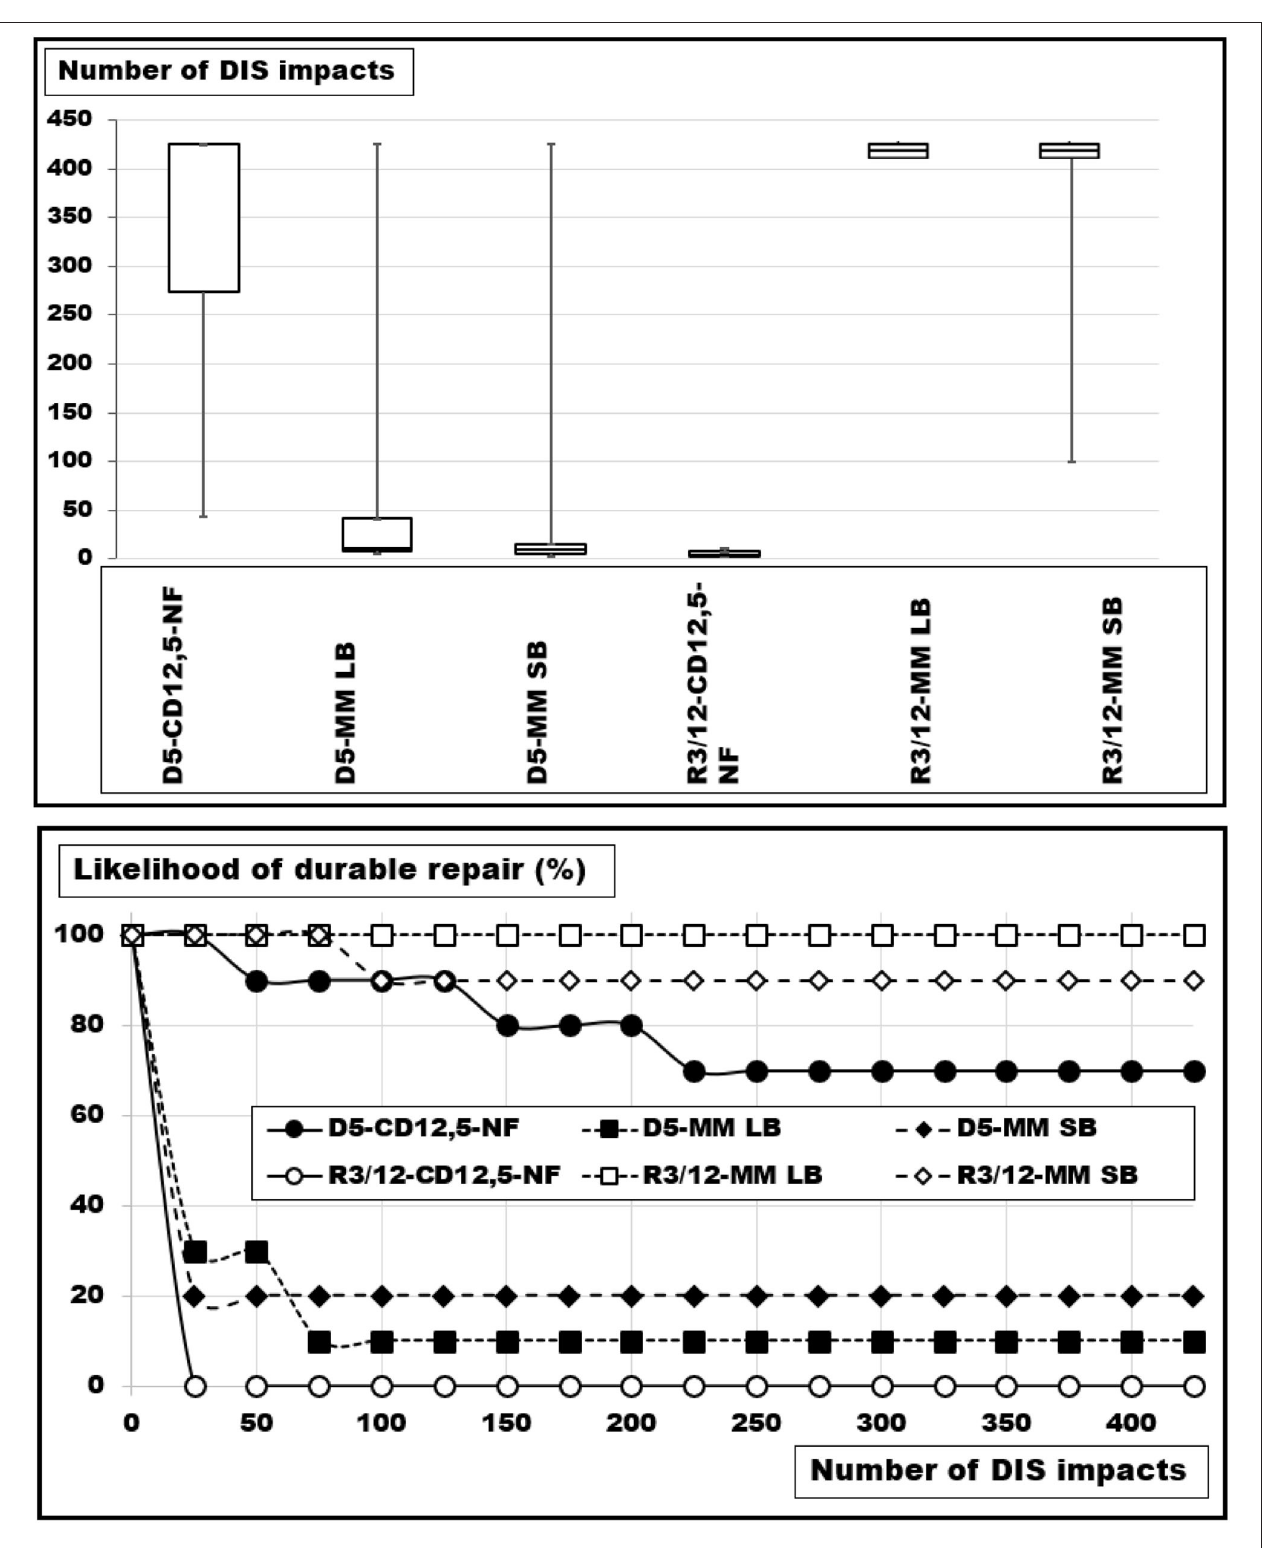
FIGURE 7 | (Top) Box-and-whisker-plots and (bottom) probability curves of round (D) and rhomboid (R) defects of 20 cm ² (D: with a diameter of 5cm and R: with a long axis of 12.1cm and a short axis of 3cm) bridged with a round Dynamesh® Cicat with a diameter of 12.5cm or closed with 2–0 Monomax® in the large (LB) and the small bite (SB) technique, each with a suture-to-incision ratio above 4:1. The differences are significant (Kruskal-Wallis test: p < 0.00005).